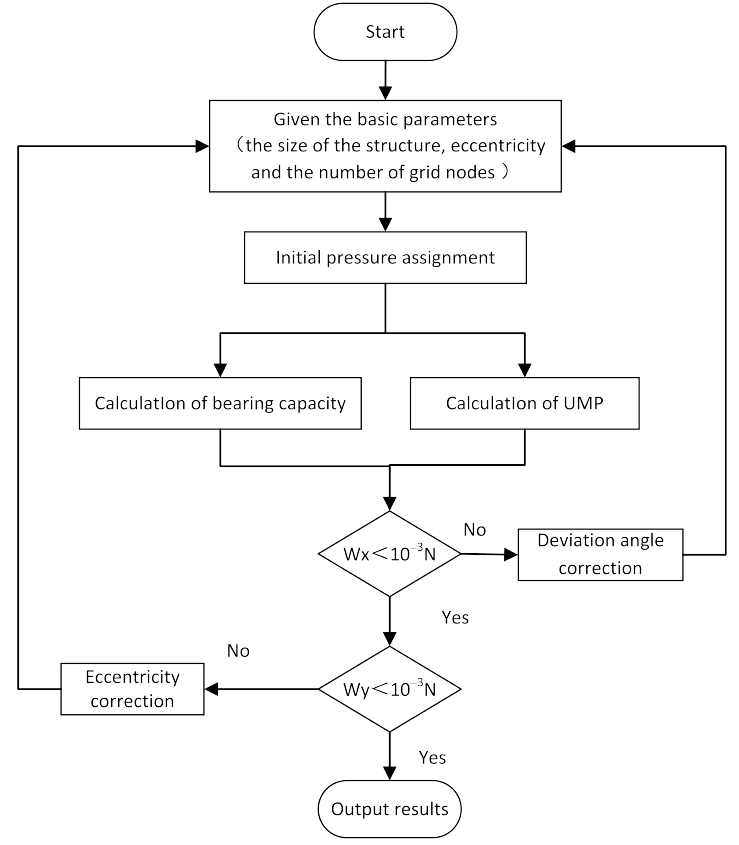
Figure 5. Calculation flowchart considering